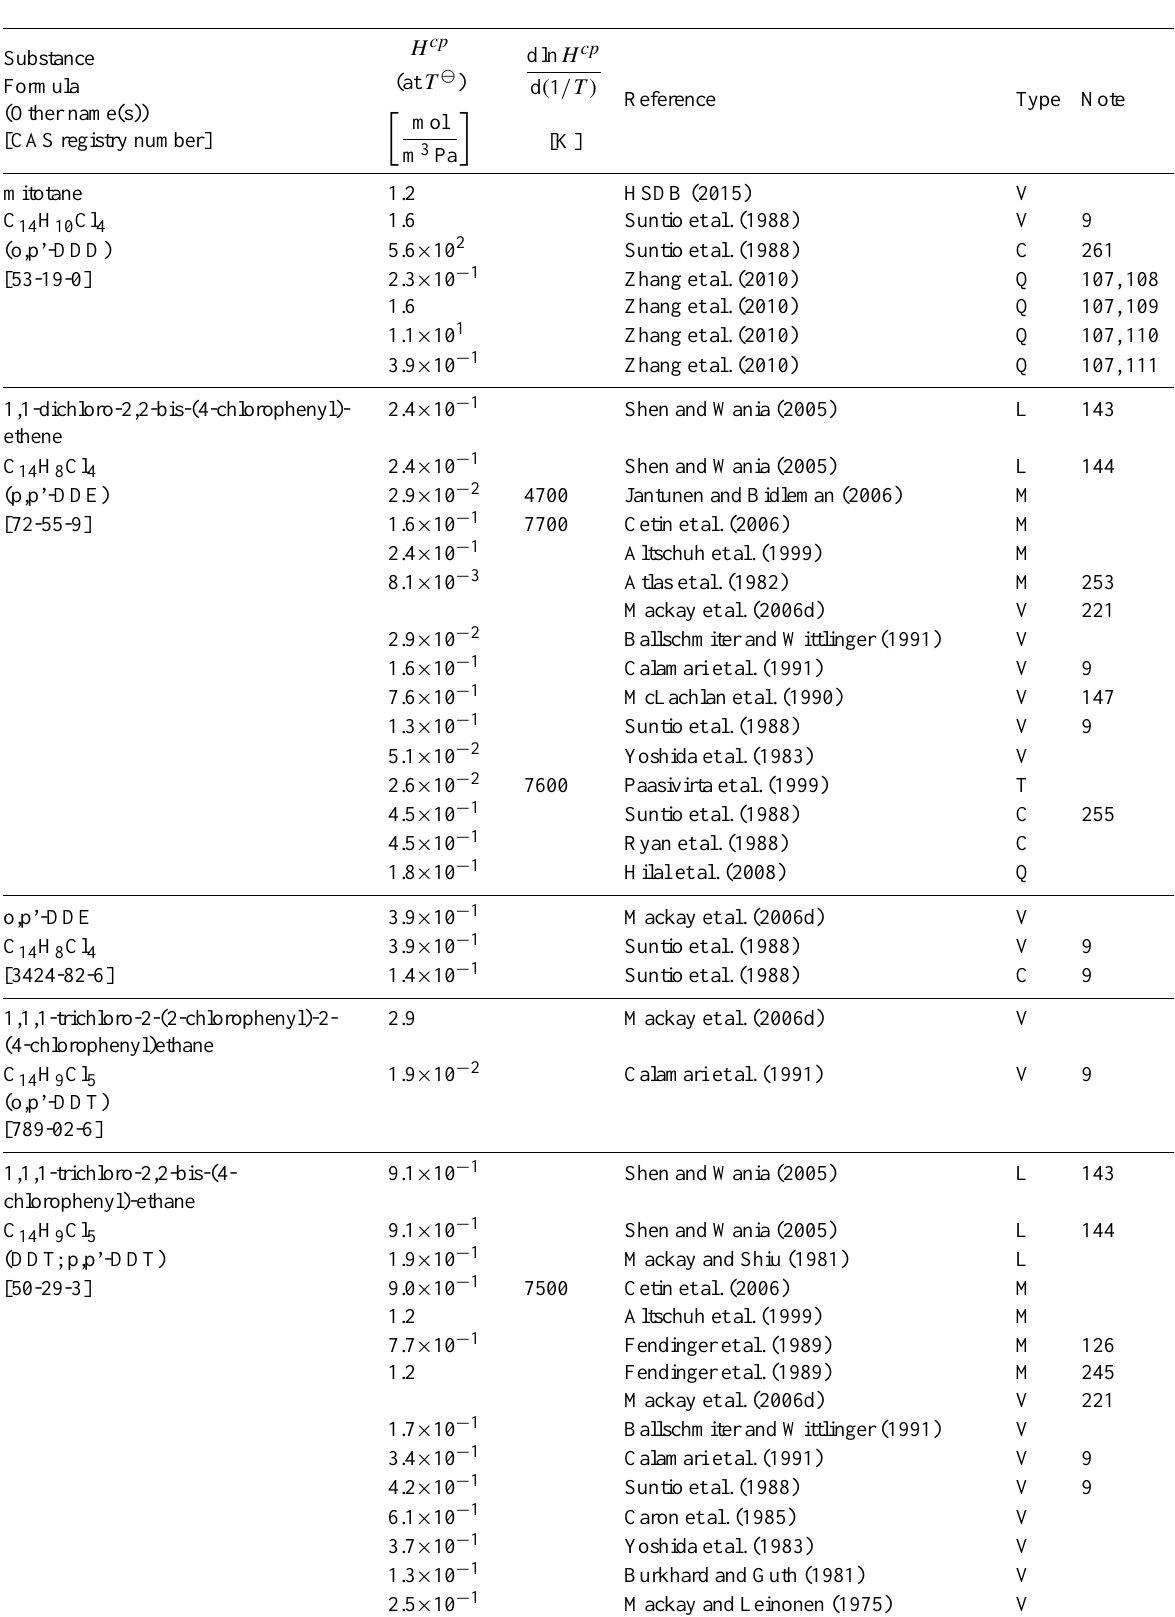
Table 6: Henry’s law constants for water as solvent